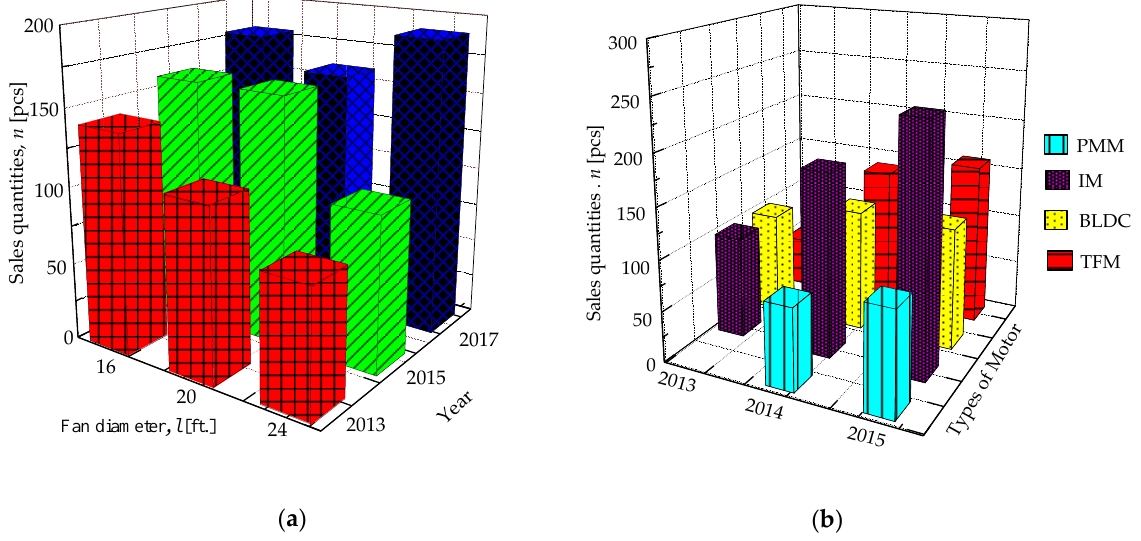
Figure 9. Product features sales ( a ) Fan diameter ( b ) Motor